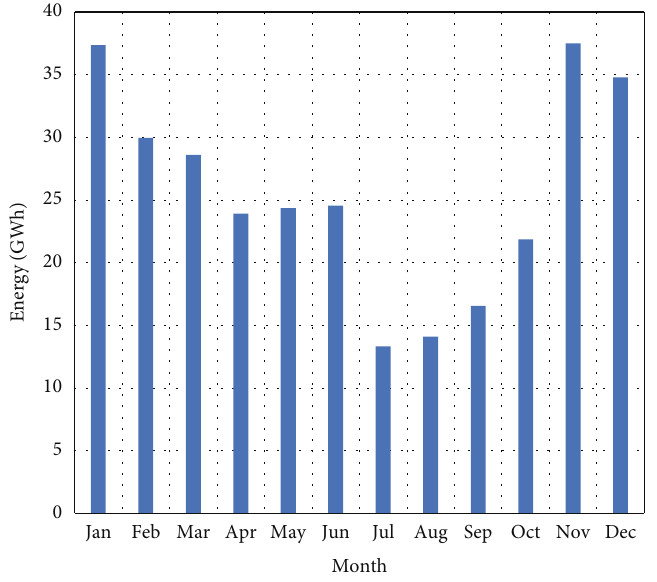
Figure 7: Monthly energy generation for